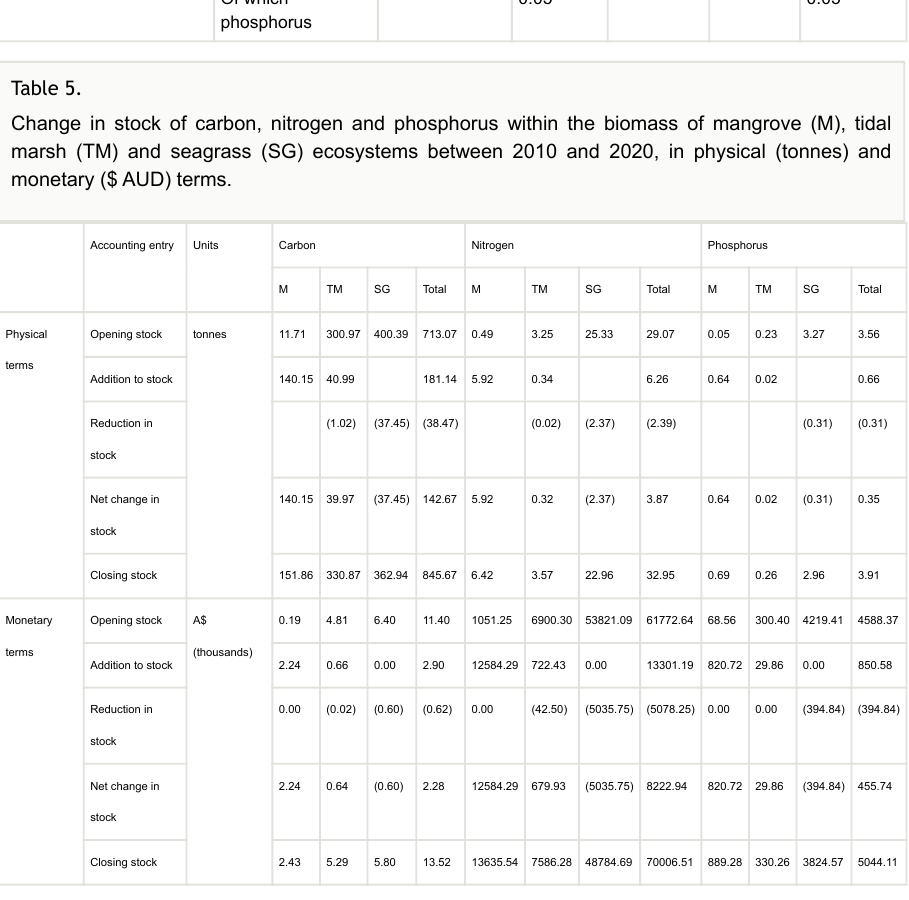
The capture of N and P into biomass was estimated to increase by 13% and 9%, respectively between 2010 and 2020 (Table 5). The contraction of seagrass decreased capture of N by 2.37 tonnes N, which was offset by the expansion of mangroves and tidal marsh, leading to a net change of 3.87 tonnes N. Similarly, P capture in biomass increased by 0.35 tonnes P, with mangroves estimated to increase P capture by 1110% between